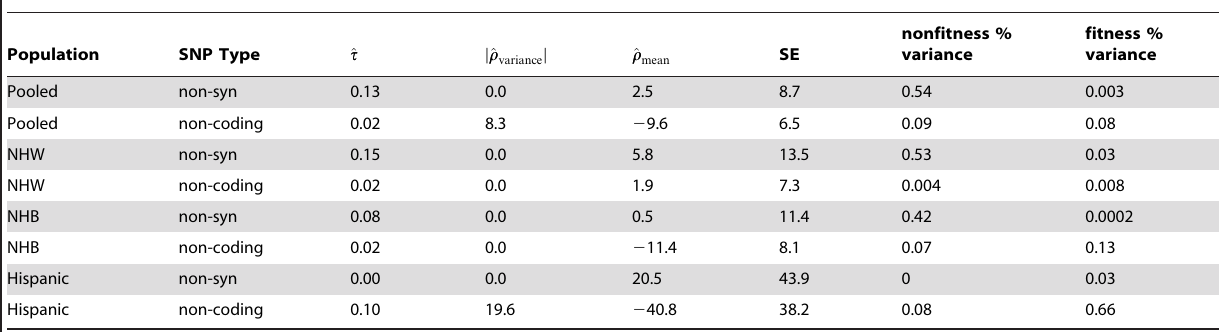
Table 2. Model fit for